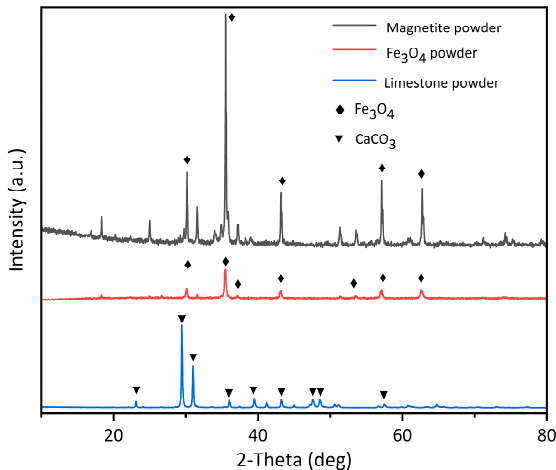
Figure 3. XRD of the Fe 3 O 4 powder, the magnetite powder, and the limestone powder.